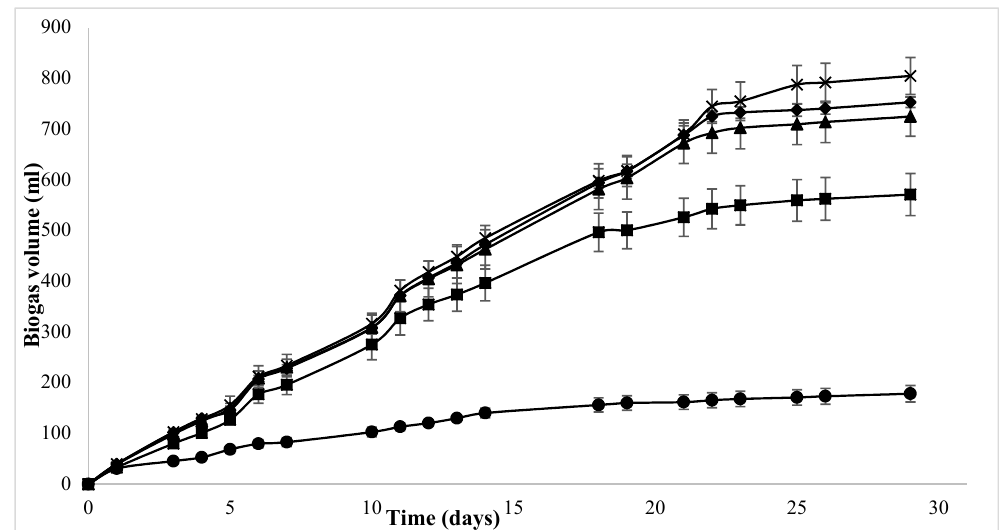
Figure 2. Accumulated biogas volumes (mL) for E-, E-TE- and E-Se-supplemented BMP assays over a 30-day period, where ● = blank, ■ = control, × = E, ♦ = E-TE, ▲ = E-Se.